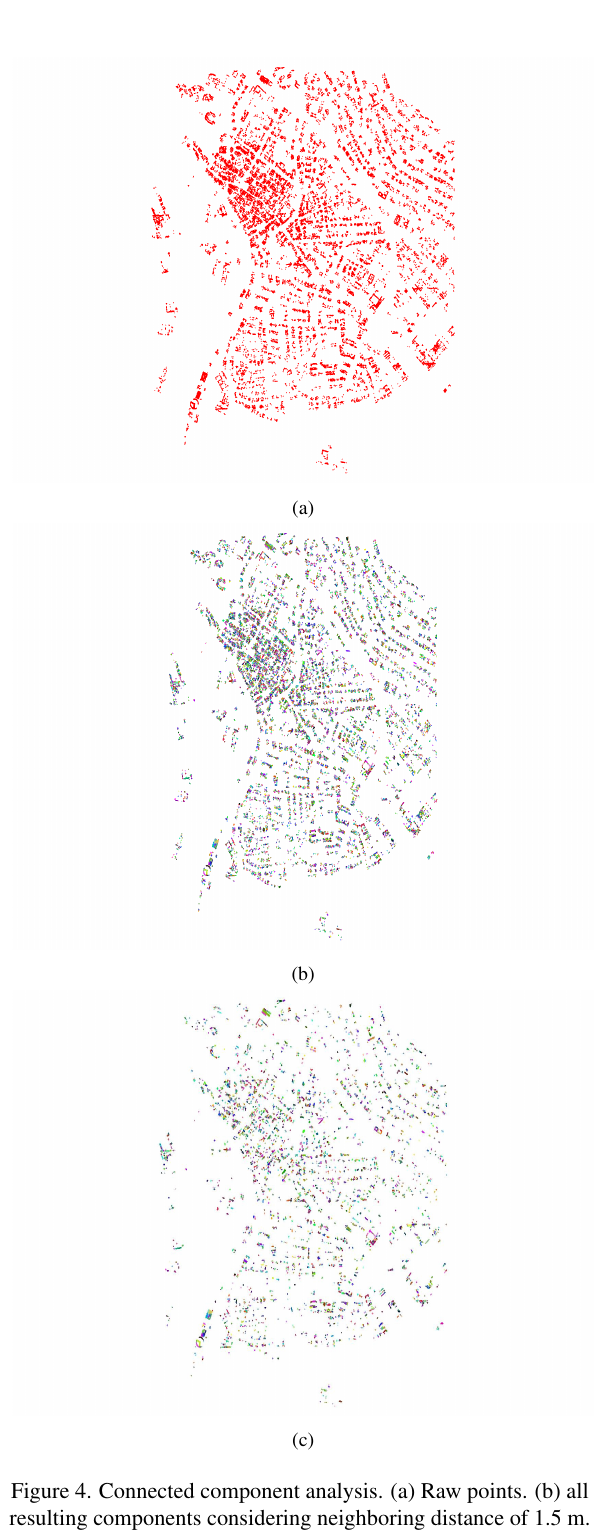
Figure 4. Connected component analysis. (a) Raw points. (b) all resulting components considering neighboring distance of 1.5 m. (c) components with size greater than five